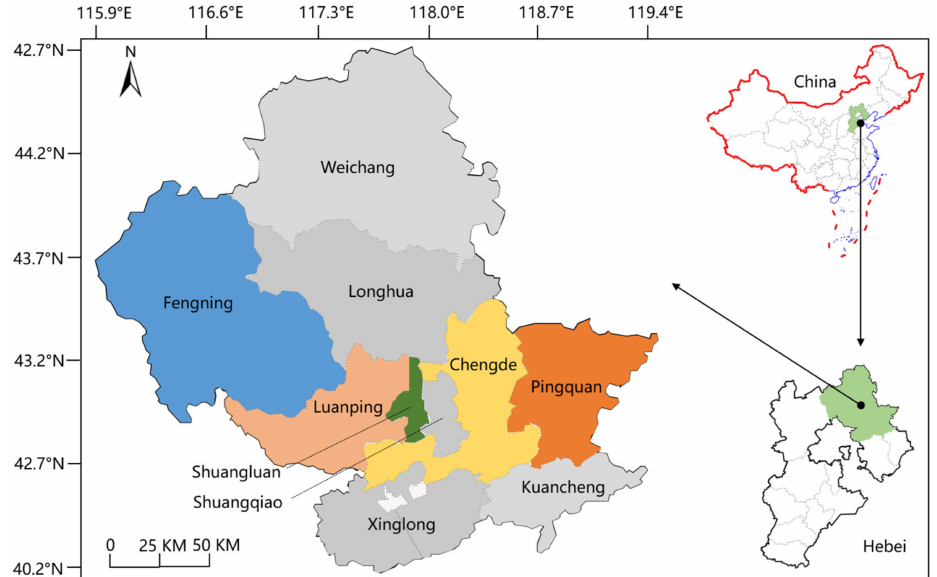
Figure 2. Study sites of Chengde City, Hebei province in